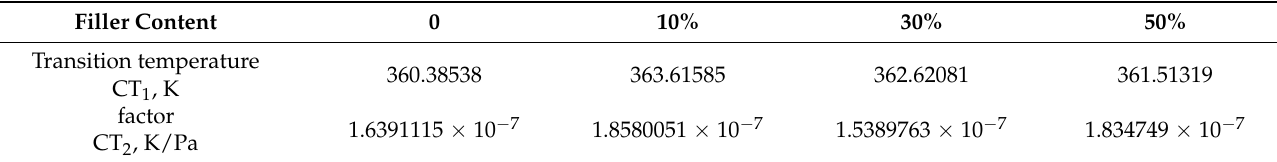
Table 2. Phase change temperatures for pure PSB and composite with variable filler